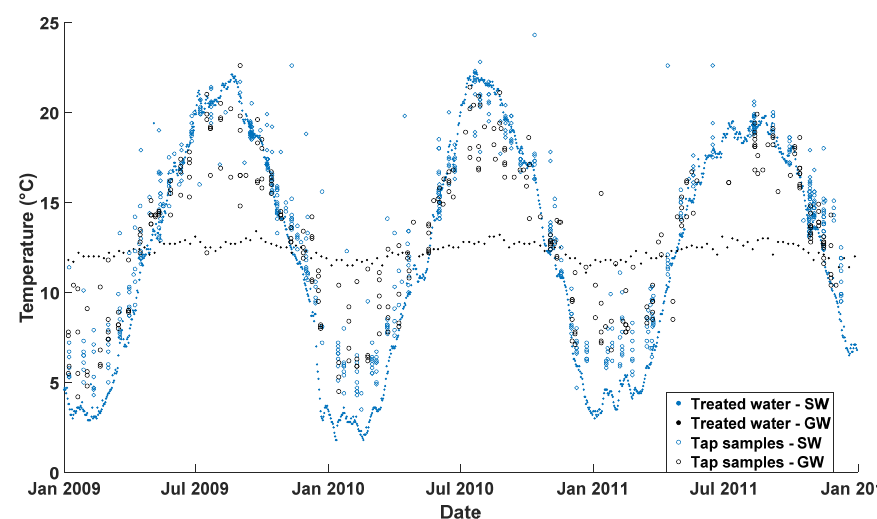
Figure 1. Measured water temperature at two pumping stations in The Netherlands—one from surface water (SW) and the other from ground water (GW)—and the respective temperatures at the tap measured at random locations in the separate drinking water distribution system (DWDS) [29].